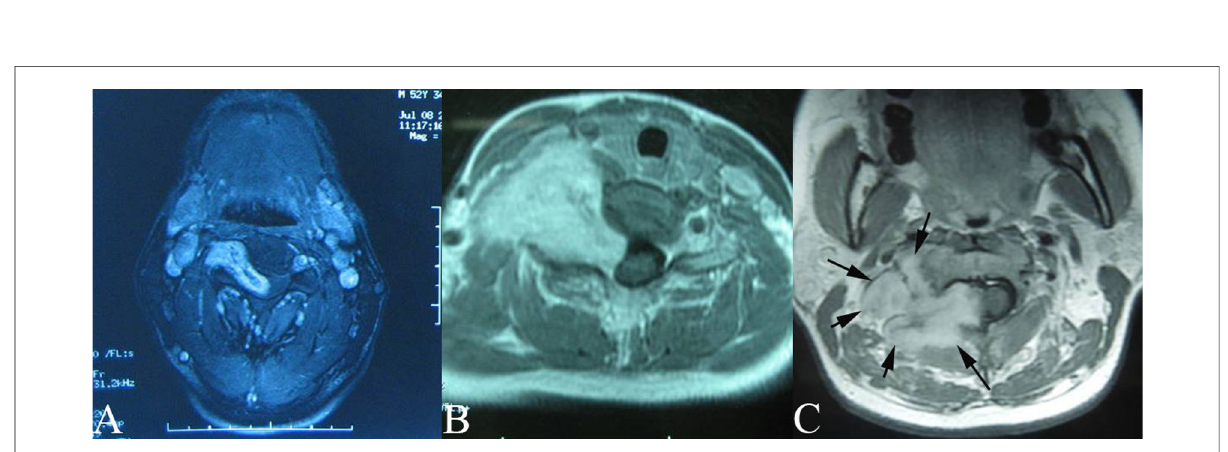
FIGURE 2 Images and classi fi cation of dumbbell cervical neuromas ( A ): type A, intraspinal tumor with extension through the intervertebral foramen to theparaspinal space. ( B ): Type B, Paravertebral tumor with extension to the intervertebralforamen without compressing spinal cord. ( C ): Type C, Giant type which consisted of alarge extra as well as intraspinal tumor compressing spinal cord with destruction of partialvertebral body or lamina plate.